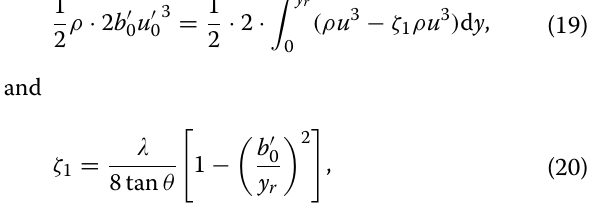
Figure 4 Description of the jet